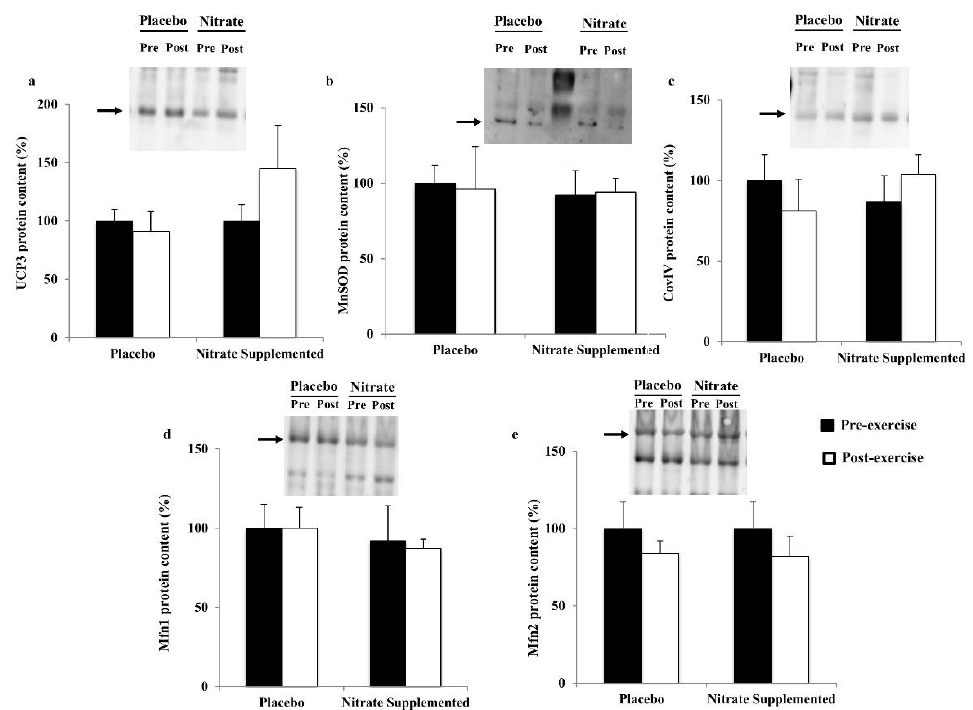
Figure 3. Effects of exercise and nitrate intake on mitochondrial and antioxidant protein levels in PBMCs from metabolic syndrome patients: ( a ) Uncoupling protein 3 (UCP3); ( b ) manganese superoxide dismutase (MnSOD); ( c ) cytochrome c oxidase subunit IV (CoxIV); ( d ) mitofusin 1 (Mfn1); ( e ) mitofusin 2 (Mfn2). Results represent mean ± SEM. Statistical analysis: two-way ANOVA. No significant effects were found, p < 0.05.